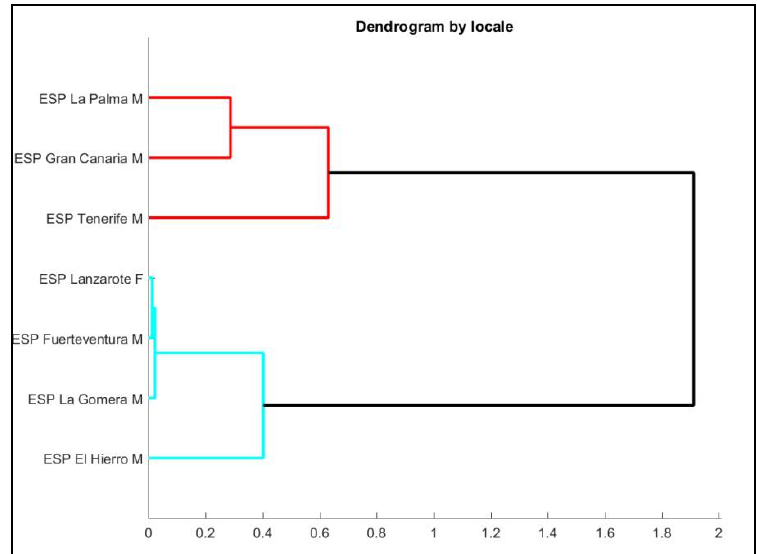
Figure 16. Dendrogram of SVO + Exp declarative vs. interrogative sentences by areas (vertical axis) and distance values along the horizontal axis.